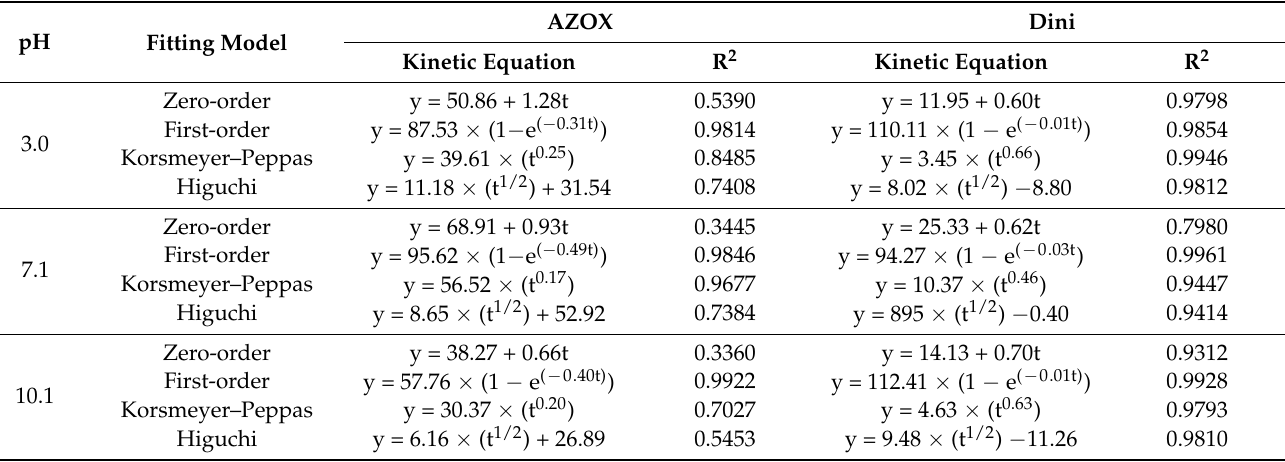
Table 3. Correlation coefficient, rate constant, and half-life obtained by fitting the release data of AZOX and Dini from AZOX@Dini@NH 2 -Al-MIL-101 at different pH values of 3.0, 7.1, and 10.1 using five different kinetic mathematical